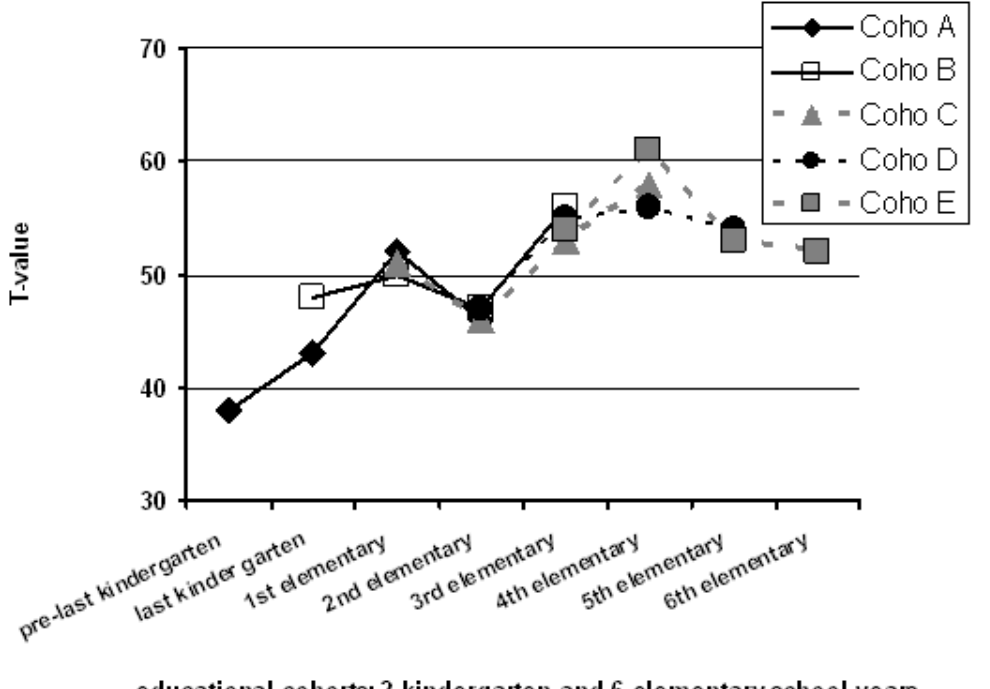
Figure 2. Cross-sequential results on ideational fluency in the Luxembourg sample.